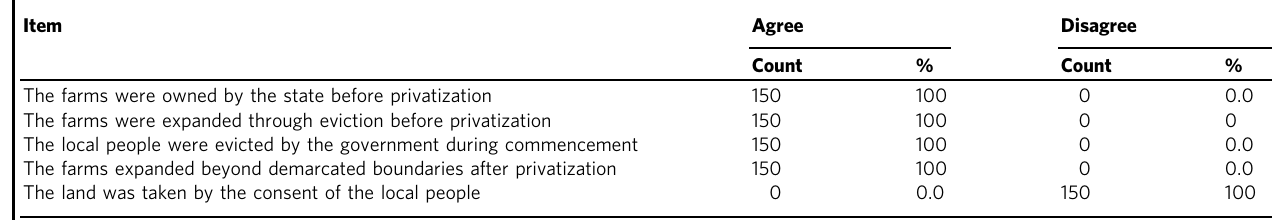
Table 1 The perception of local communities about ownership of Birr and Ayehu commercial farms. Item The farms were owned by the state before